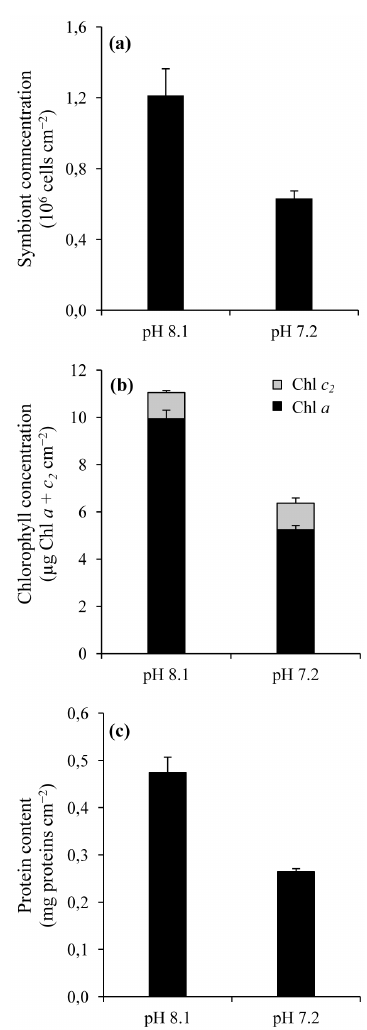
Fig. 1. (a) Symbiont, (b) chlorophyll and (c) protein concentrations for Stylophora pistillata at pH T 8.1 and 7.2. Data are means ± stan- dard error of means of n = 4